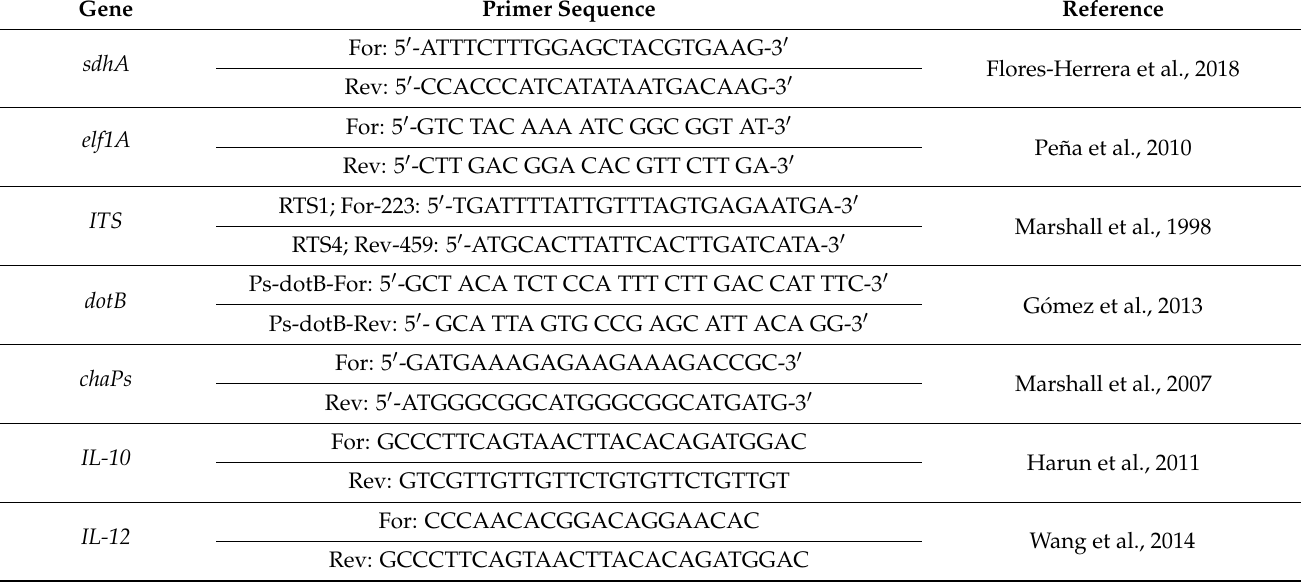
Table 1. Primers for the real-time PCR gene expression analysis used in our study.